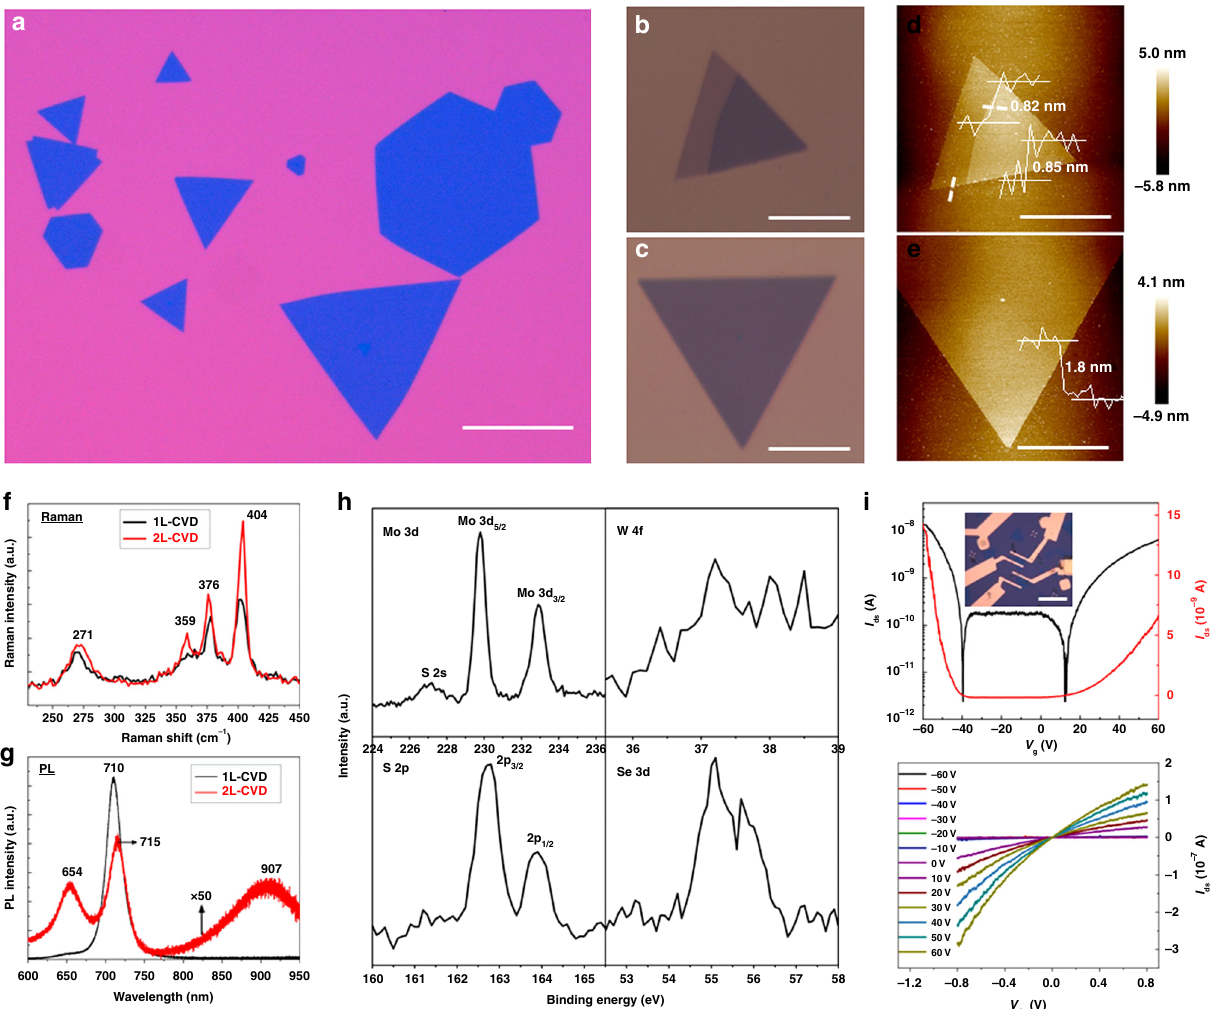
Fig. 6 Characterization of the quaternary alloy Mo 1 − x W x S 2(1 − y ) Se 2 y bilayer crystals. a – c The representative optical images as well as d , e AFM surface morphologies of the as-grown quaternary alloy Mo 1 − x W x S 2(1 − y ) Se 2 y bilayer crystals. f Raman spectra and g PL spectra of the as-grown quaternary alloy Mo 1 − x W x S 2(1 − y ) Se 2 y bilayer and monolayer crystals. h XPS spectra of the as-grown quaternary alloy Mo 1 − x W x S 2(1 − y ) Se 2 y bilayer crystals. i Transfer and output characteristics of the back-gated FET devices fabricated on the Mo 1 − x W x S 2(1 − y ) Se 2 y bilayer samples. The inset is one typical optical image of